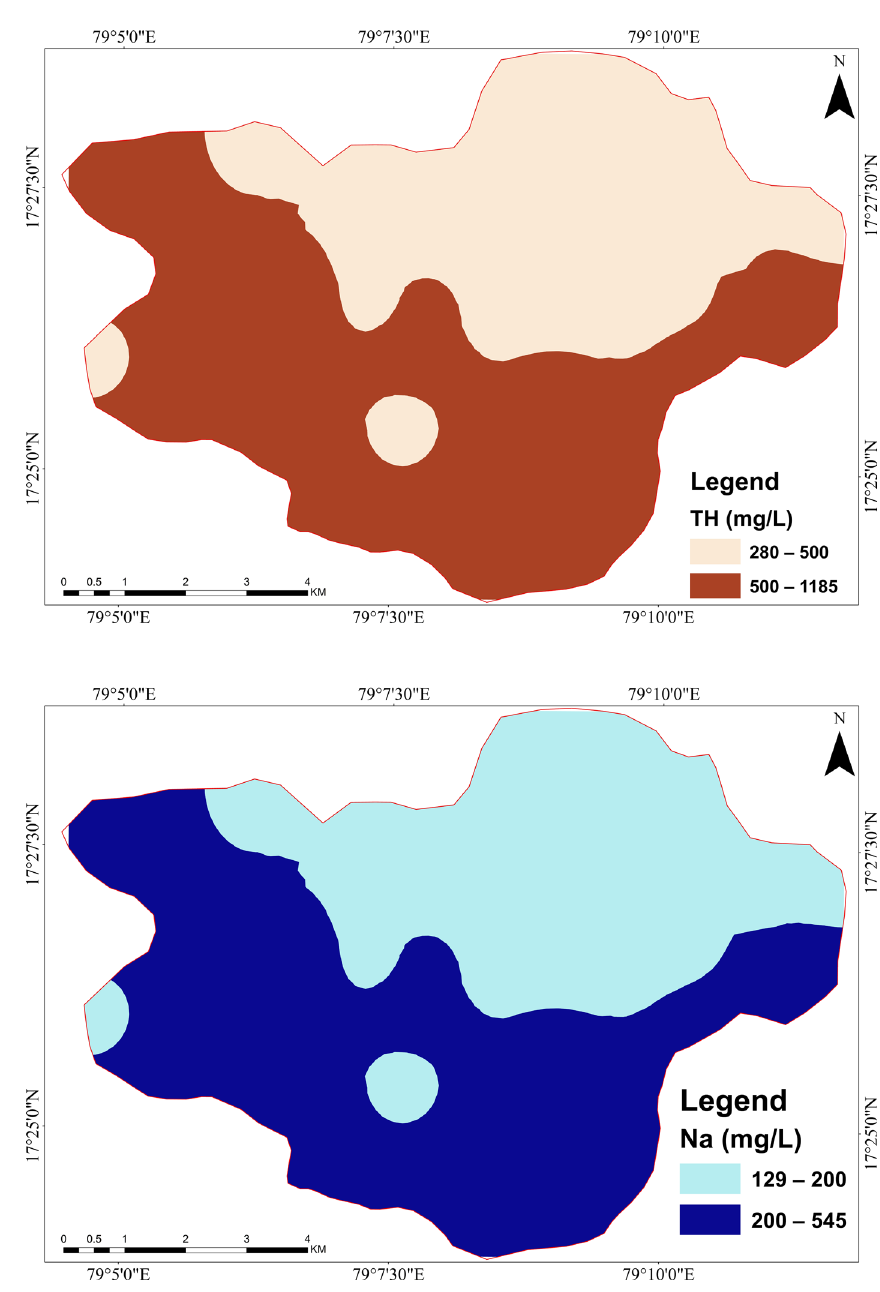
Fig. 5 Spatial distribution map of TH in Mothkur region, Tel- angana State, South India